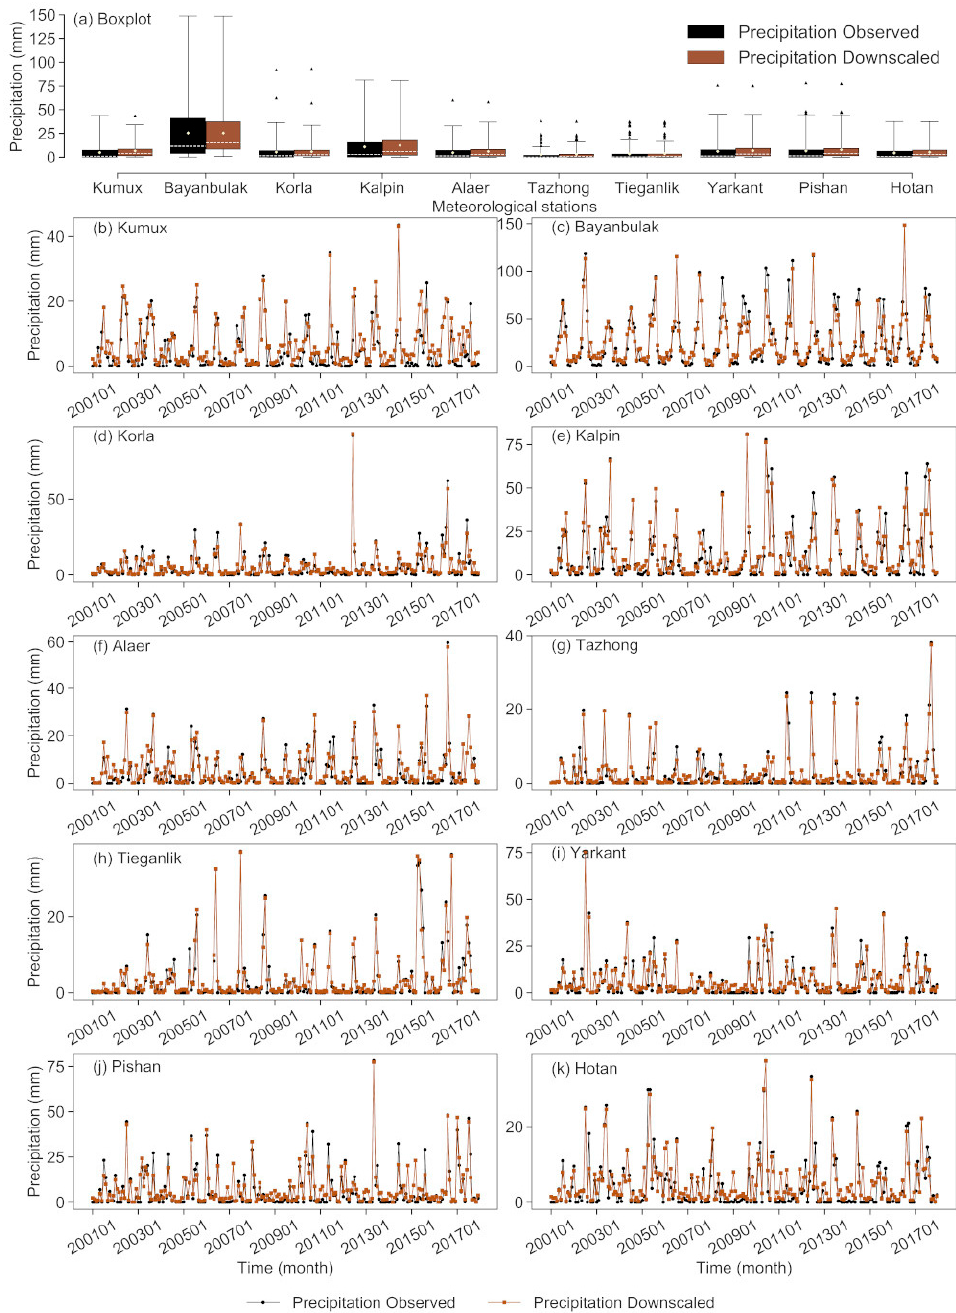
Figure 7. The outliers of precipitation from 2001 to 2017. ( a ) The boxplot of observation data and downscaling results for each station. ( b – k ) present a comparison of the monthly precipitation between observation data and the downscaling of each station.